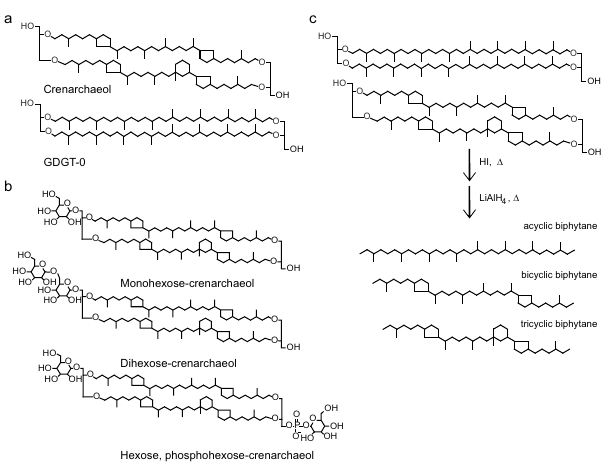
Fig. 1. Structures of crenarchaeol and GDGT-0 (a) , IPL- crenarchaeol species (b) and biphytanyl chains released from cre- narchaeol and GDGT-0 by chemical degradation (c) .